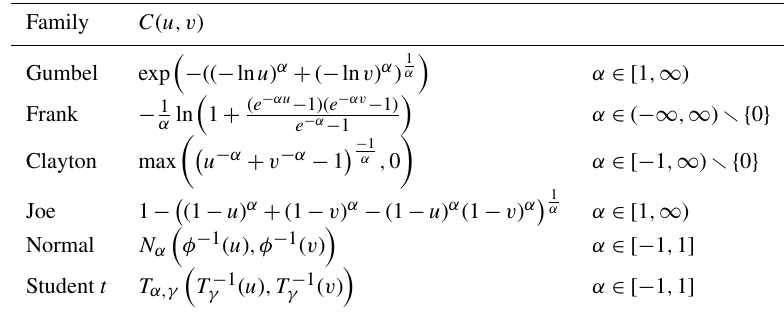
Table 1. Six bivariate copula families.